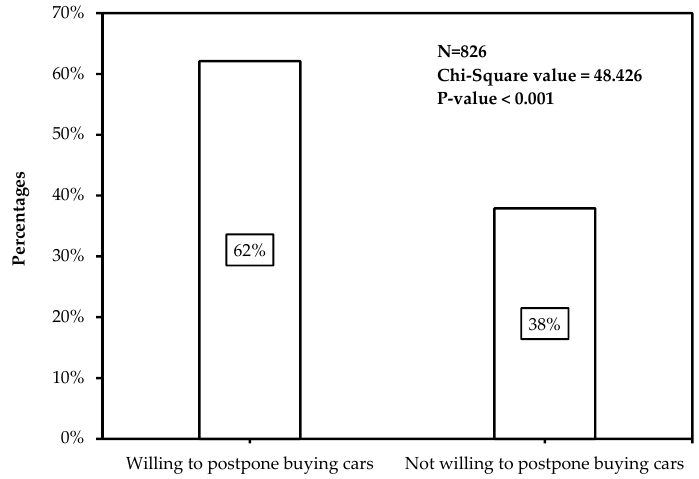
Figure 3. Participants’ willingness to forgo car purchases.